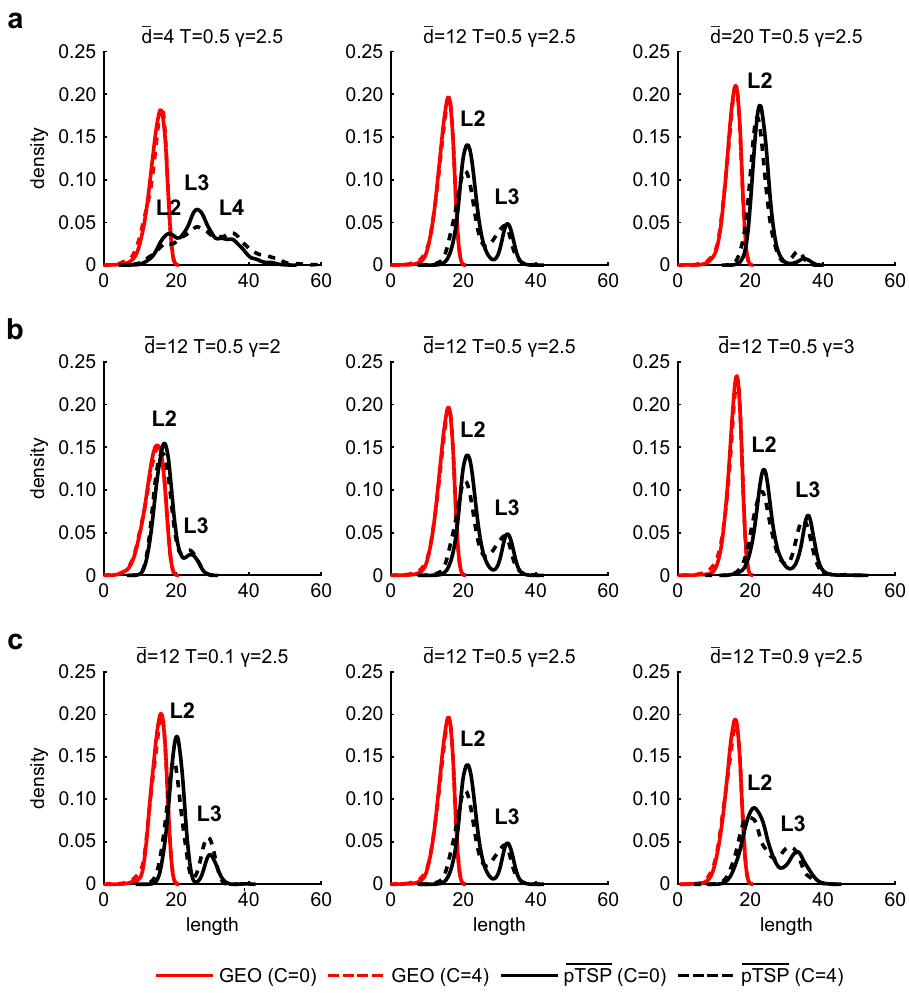
Fig. 2 | Comparison ofGEO and pTSP distributionsinhyperbolic networks. For each subplot, the nPSO network has been generated with parameters N = 100, C = [0, 4] and values of (cid:1) d , T , γ as indicated on top of each subplot. In particular:( a ) we fi xed T = 0.5, γ =2.5andvaried (cid:1) d = [4,12, 20];( b )we fi xed (cid:1) d = 12, T =0.5and varied γ = [2, 2.5, 3]; ( c ) we fi xed (cid:1) d = 12, γ = 2.5 and varied T = [0.1, 0.5, 0.9]. The different results for C = 0 and C = 4 are shown within each subplot with a solid and dashed line,respectively.Foragivennetwork,wehavecomputedthegeodesics(GEO)and